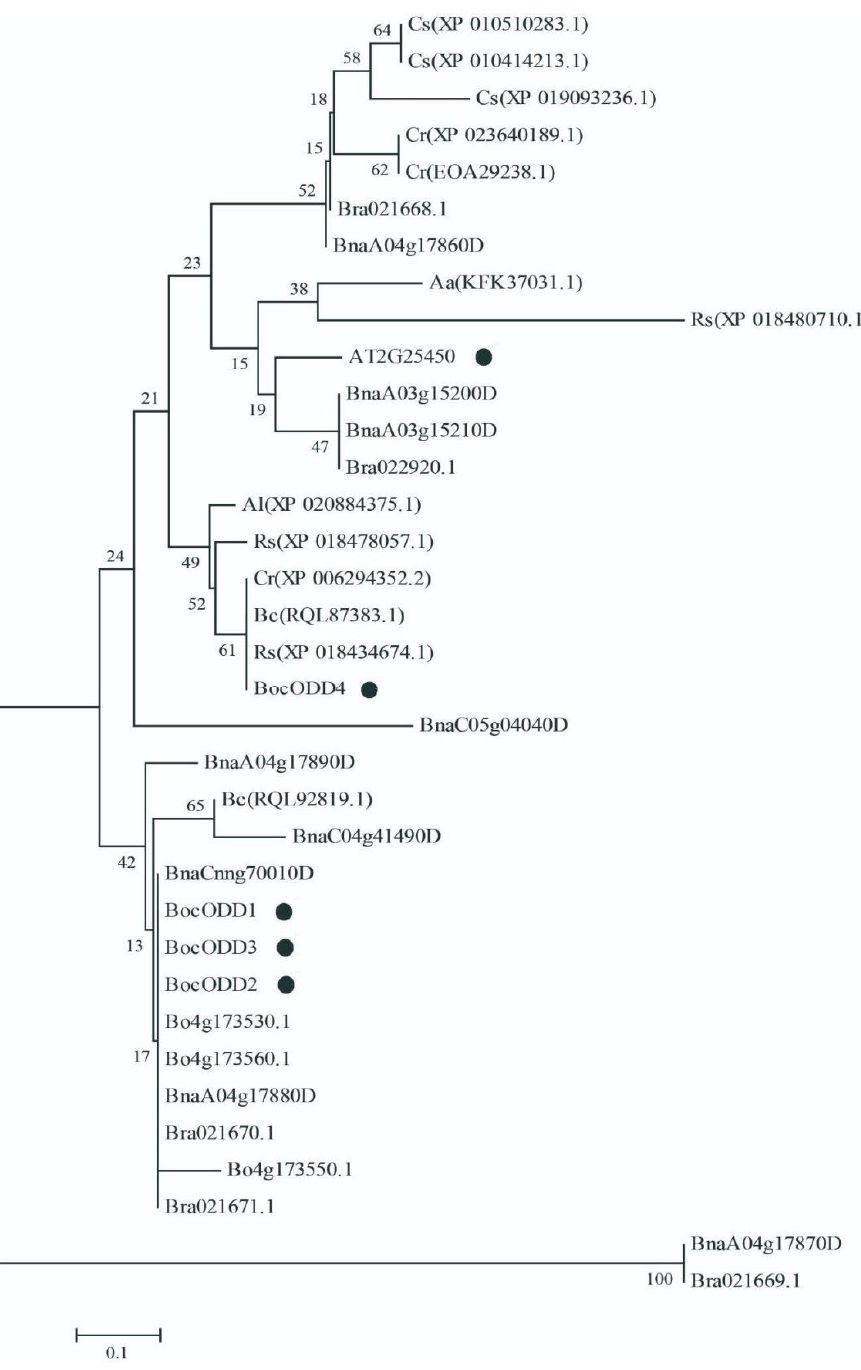
Figure 5. Phylogenetic analysis of ODDs in the Brassica family. This tree was constructed by MEGA 6.06 software. Bootstrap values with 1000 replicates are given as percentages; ODD genes were listed in Supplementary Data 2.